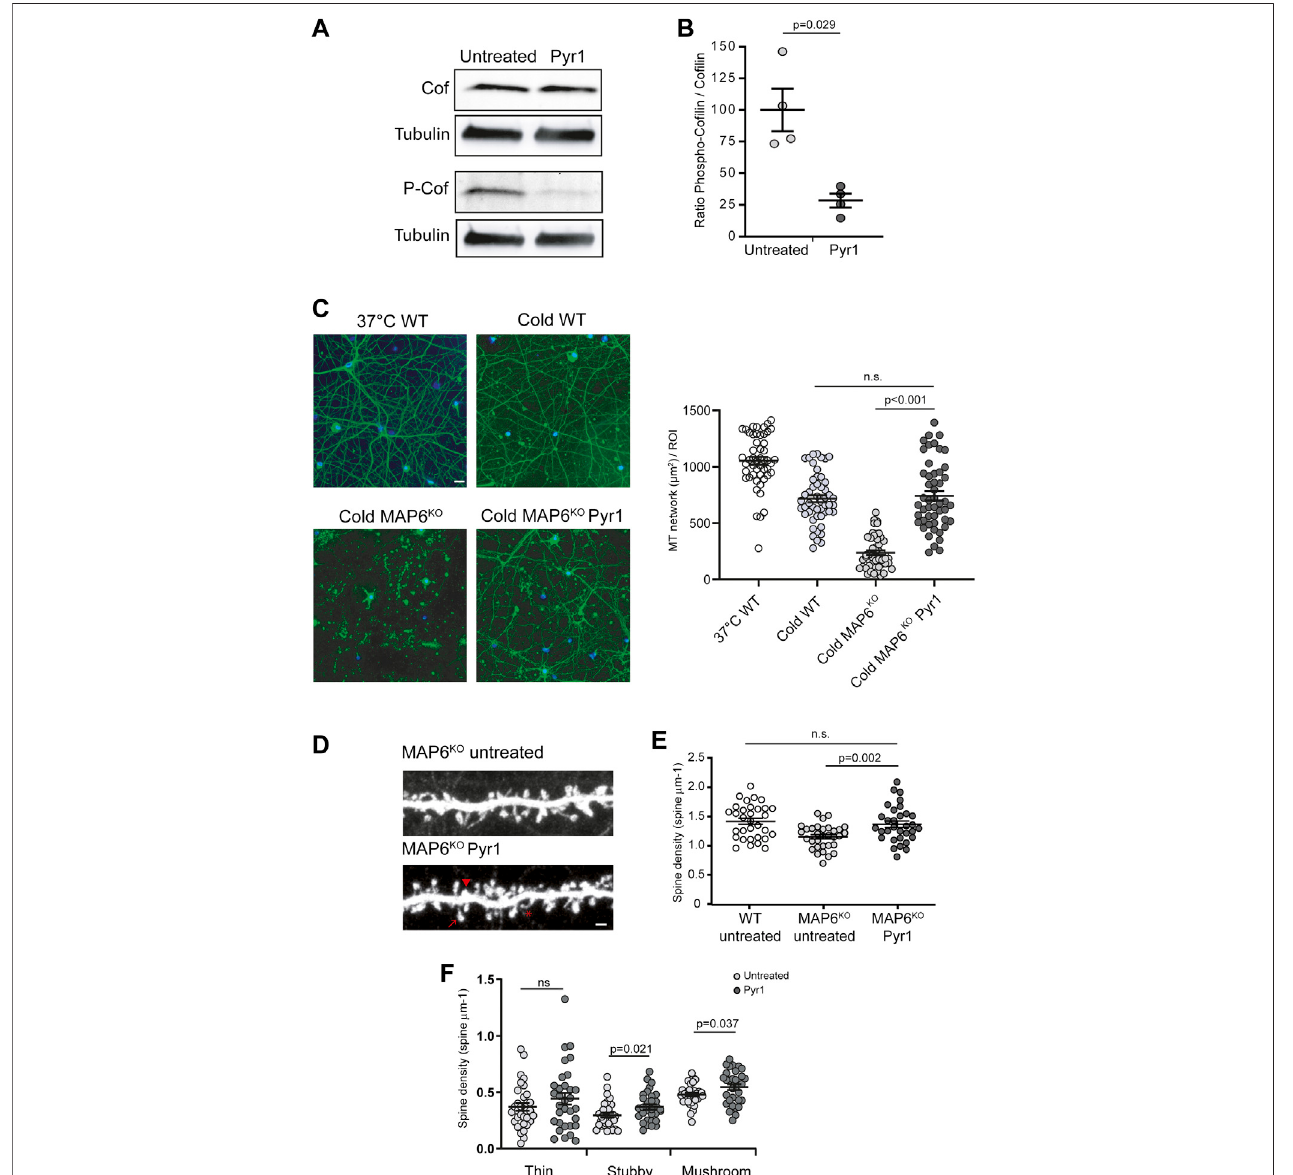
FIGURE 1 | Pyr1 modulates cytoskeleton dynamics and neuronal dendritic spine density (A,B) Effect of Pyr1 on co fi lin phosphorylation. Hippocampal neurons, untreatedortreatedwith20 μ MPyr1for30 minwerelysed,andproteinsanalyzedbywesternblot.Therelativeamountsofco fi linandphosphoco fi linwereassessed. (A) Representative western blot with samples from untreated and Pyr1-treated neurons. (B) Quanti fi cation of phosphoco fi lin/co fi lin ratio, values are expressed as a proportion of the mean for untreated samples (100 ± 16.8 for untreated, 28.4 ± 5.4 for Pyr1 treated neurons). Mann-Whitney test, p value is indicated, n (cid:2) 4 independentexperiments (C) EffectofPyr1onMTstability.Wildtypeneuronswereeithernon-coldexposed(37 ° CWT)orcold-exposed(coldWT).UntreatedMAP6KO neurons and Pyr1-treated MAP6 KO neurons (30 min, 10 µM Pyr1, 37 ° C), were exposed to cold (0 ° C for 45 min). Following free tubulin extraction, cells were permeabilized and MT were labeled using anti-tubulin antibody (green); nuclei were stained with Hoechst (blue). Scale bar (cid:2) 20 µm. Quanti fi cation of MT surface was performedineachcondition.MTsurfaceperROIwere1053 ± 34for37 ° CWT;717 ± 31forcoldWT,237 ± 20forcoldMAP6KOand 742 ± 42forcoldMAP6KOPyr1- treated.Student ’ st-test, p valuesareindicated,ns:notsigni fi cant. n (cid:2) 50neuronsineachcondition (D – F) EffectofPyr1ondendriticspinedensityonMAP6KOneurons (D) Confocal image showing representative examples of dendritic segments of MAP6 KO hippocampal neurons infected with lvGFP at 17 DIV to visualize dendritic spines. Representative spines sub-types as classi fi ed by Neuron Studio software, are illustrated: star (cid:2) thin spine, arrow head (cid:2) stubby spine and arrow (cid:2) mushroom spine. Untreated MAP6 KO or Pyr1-treated neurons are shown. Scale bar (cid:2) 2 μ m Pyr1 treatment consisted in the application of 185 nM Pyr1 for 90 min to the culture. Dendritic spine density was quanti fi ed. For total spines (E) , densities were 1.41 ± 0.05 for WT neurons, 1.15 ± 0.04 and 1.34 ± 0.05 spines/µm for untreated KO and treated KO neurons, respectively. For classi fi ed spines (F) densities were: 0.37 ± 0.04 and 0.44 ± 0.05 thin spines/µm; 0.30 ± 0.02 and 0.37 ± 0.02 stubby spines/µm; 0.48 ± 0.02and 0.55 ± 0.03 mushroom-likespines/µm for untreated and Pyr1-treated neurons, respectively. Student ’ s t-test, p values are indicated, ns: not signi fi cant. n (cid:2) 30 neurons from three independent neuronal cultures for MAP6 KO neurons, n (cid:2) 32 neurons for WT neurons, from four independent cultures. One to three neurites were measured for each neuron, total length ≥ 50 µm. Values correspond to mean ± SEM.